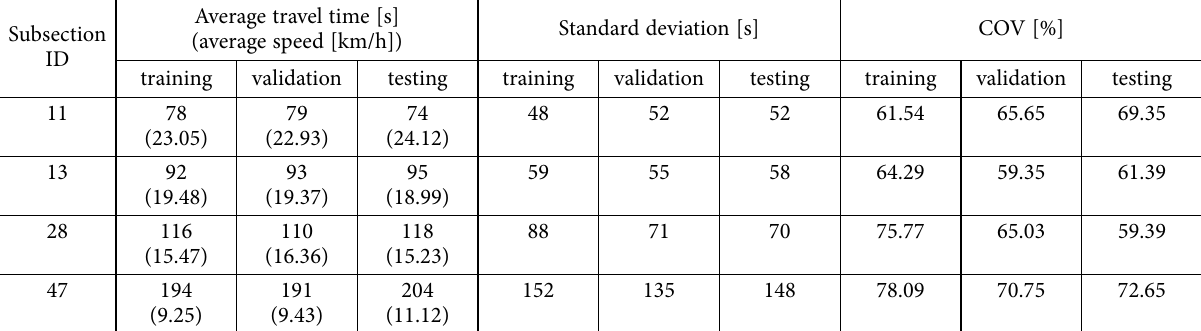
Table 3. Descriptive statistics of the data used for training, validating and testing the SVM model Subsection